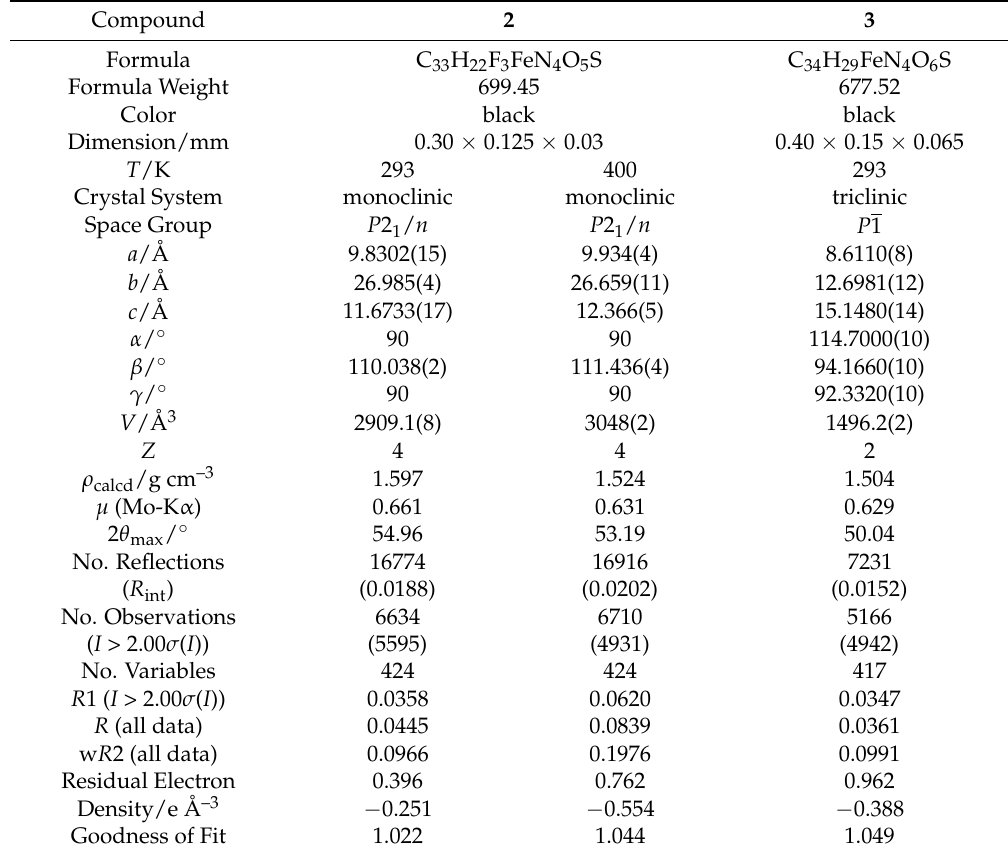
Table 4. Crystallographic data for 2 and 3